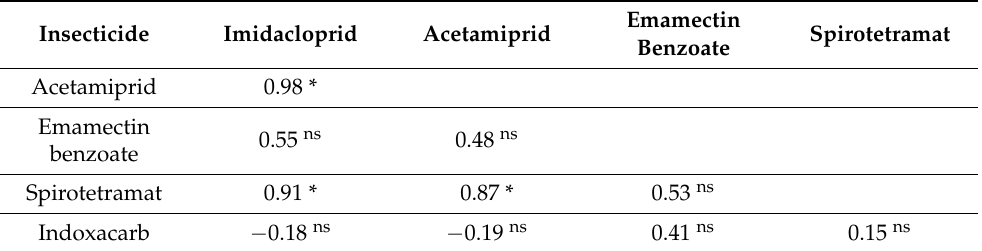
Emamectin Spirotetramat Benzoate